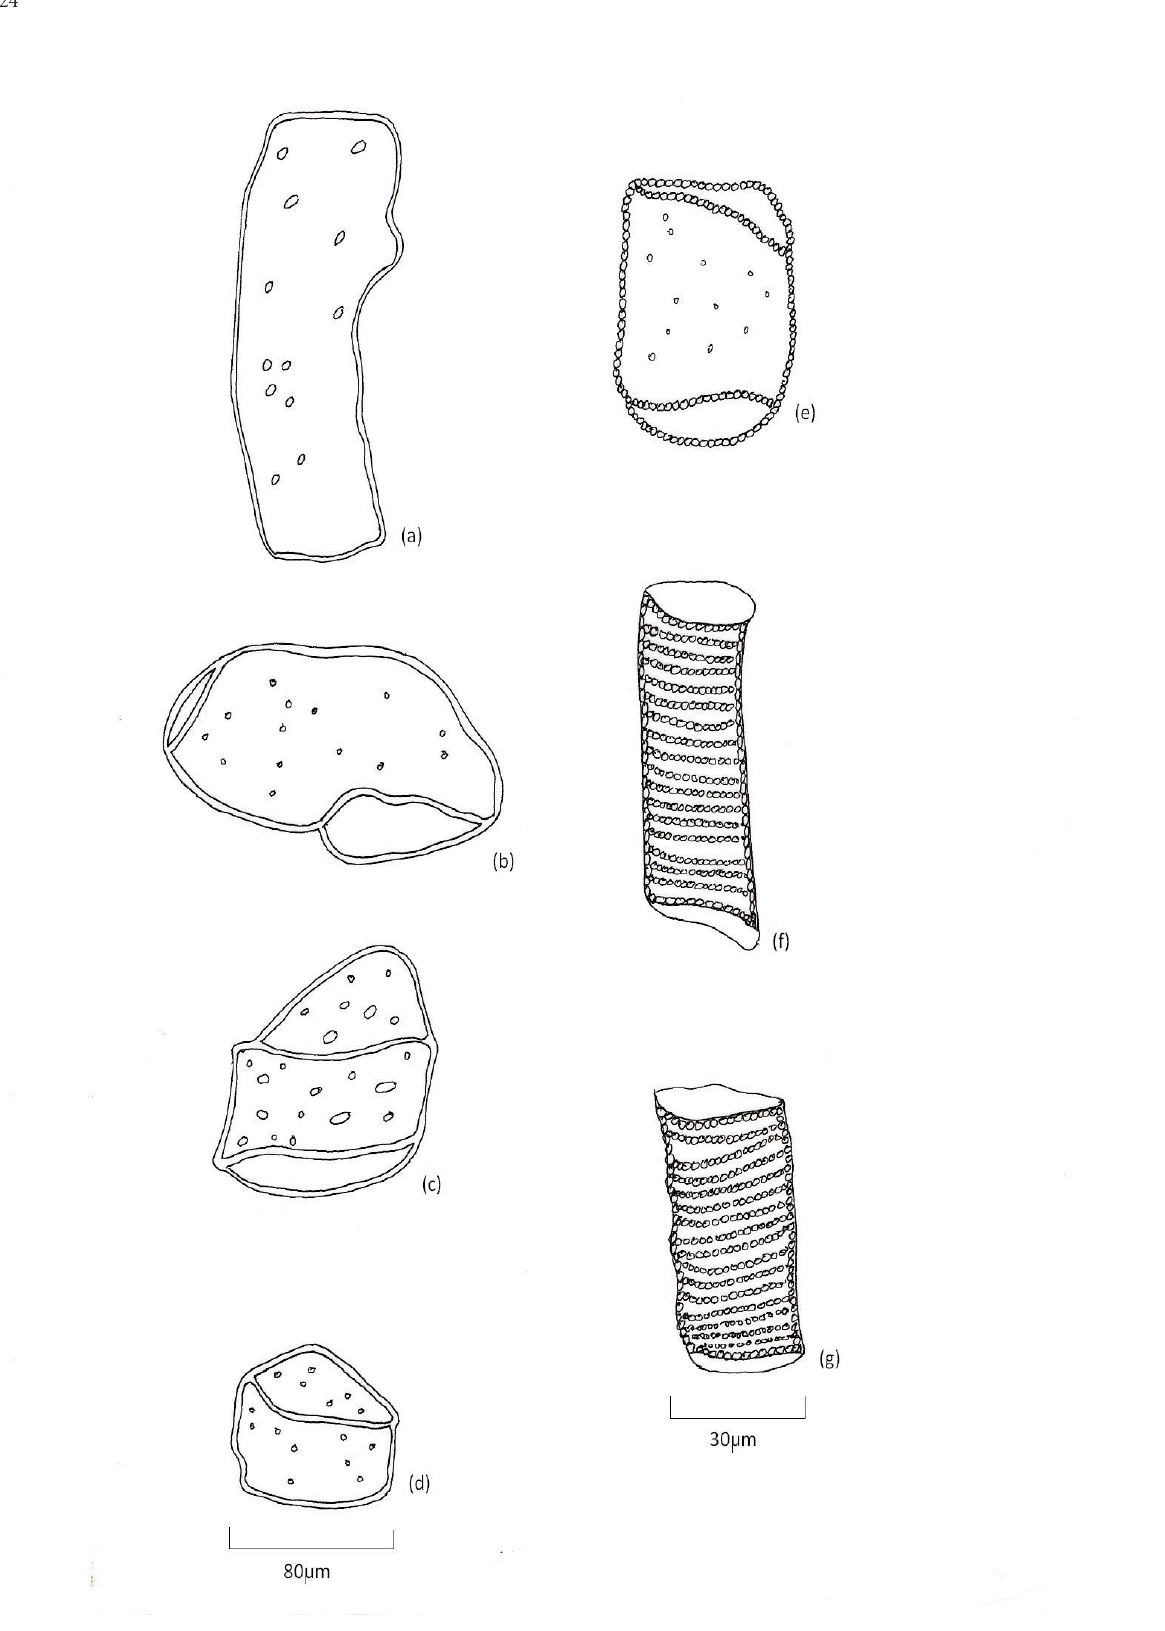
Fig. 1. Diagrammatic illustration of vessel types in Annona senegalensis ; Diagram a-e: Wide vessels types in Annona senegalensis; Diagram f-g: Narrow vessel types in Annona